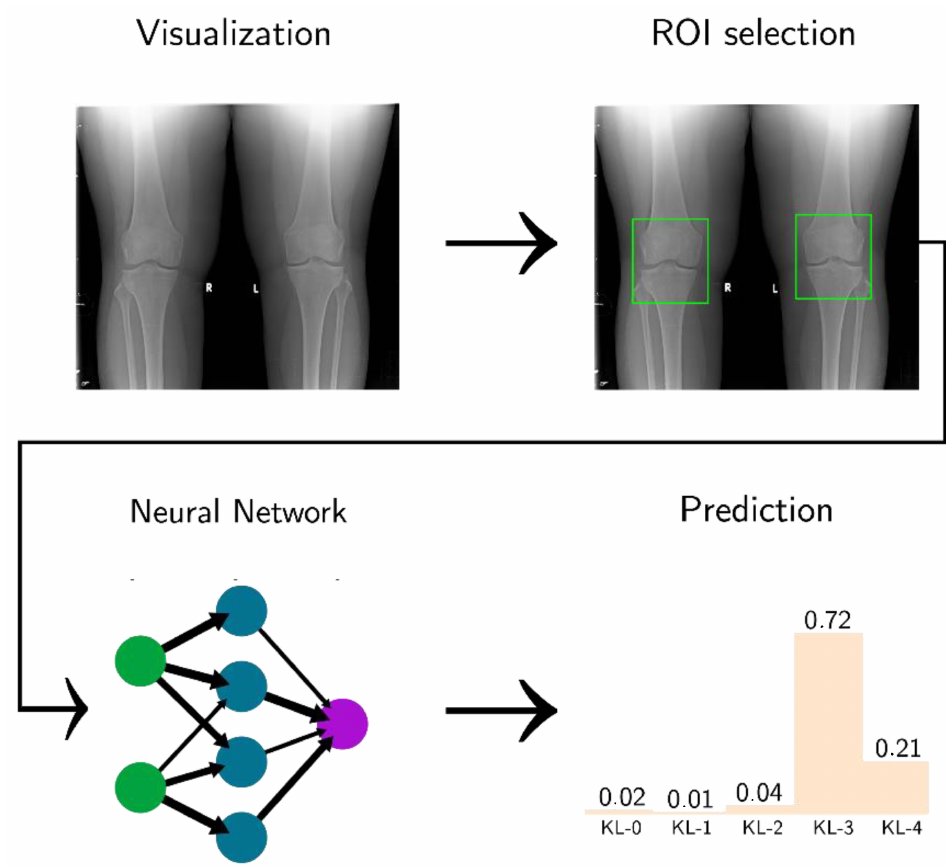
Figure 3. Software pipeline used in this project. The figure was adapted from